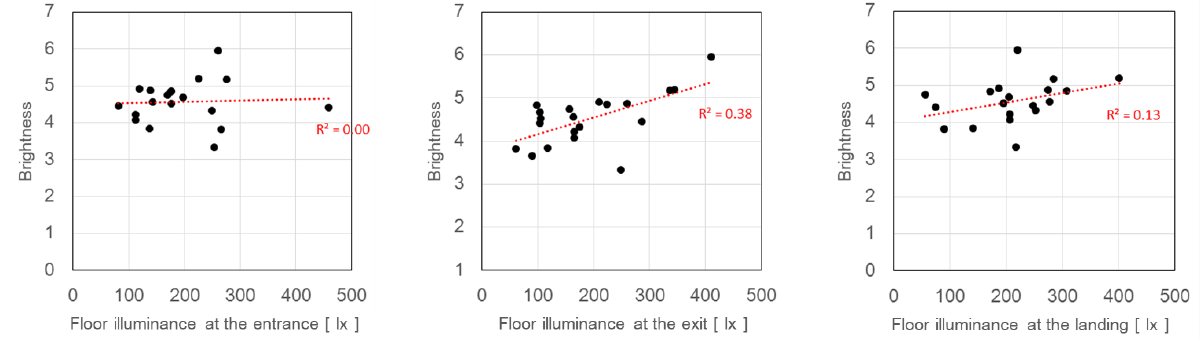
Figure 11. Correlation between illuminance and brightness evaluation results.